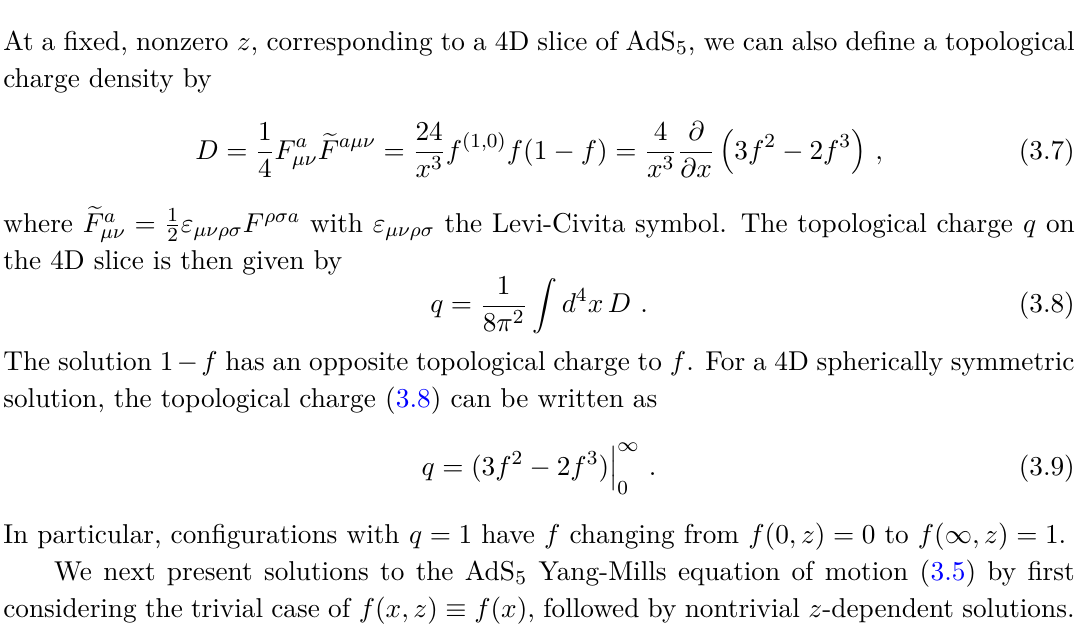
Figure 2 . Left: the uplifted 4D instanton solution (3.10) for ρ = 1 , depicting the f = 0 asymptotic region rising to f = 1 at x ∼ ρ , independent of z . Right: the instanton-anti-instanton solution (3.15) for ρ = 1 , depicting the merging of the asymptotic f = 1 regions at x ∼ z ∼ ρ from the anti- instanton and instanton. The f = 1 “plateaus” enclose a “basin” corresponding to f = 0